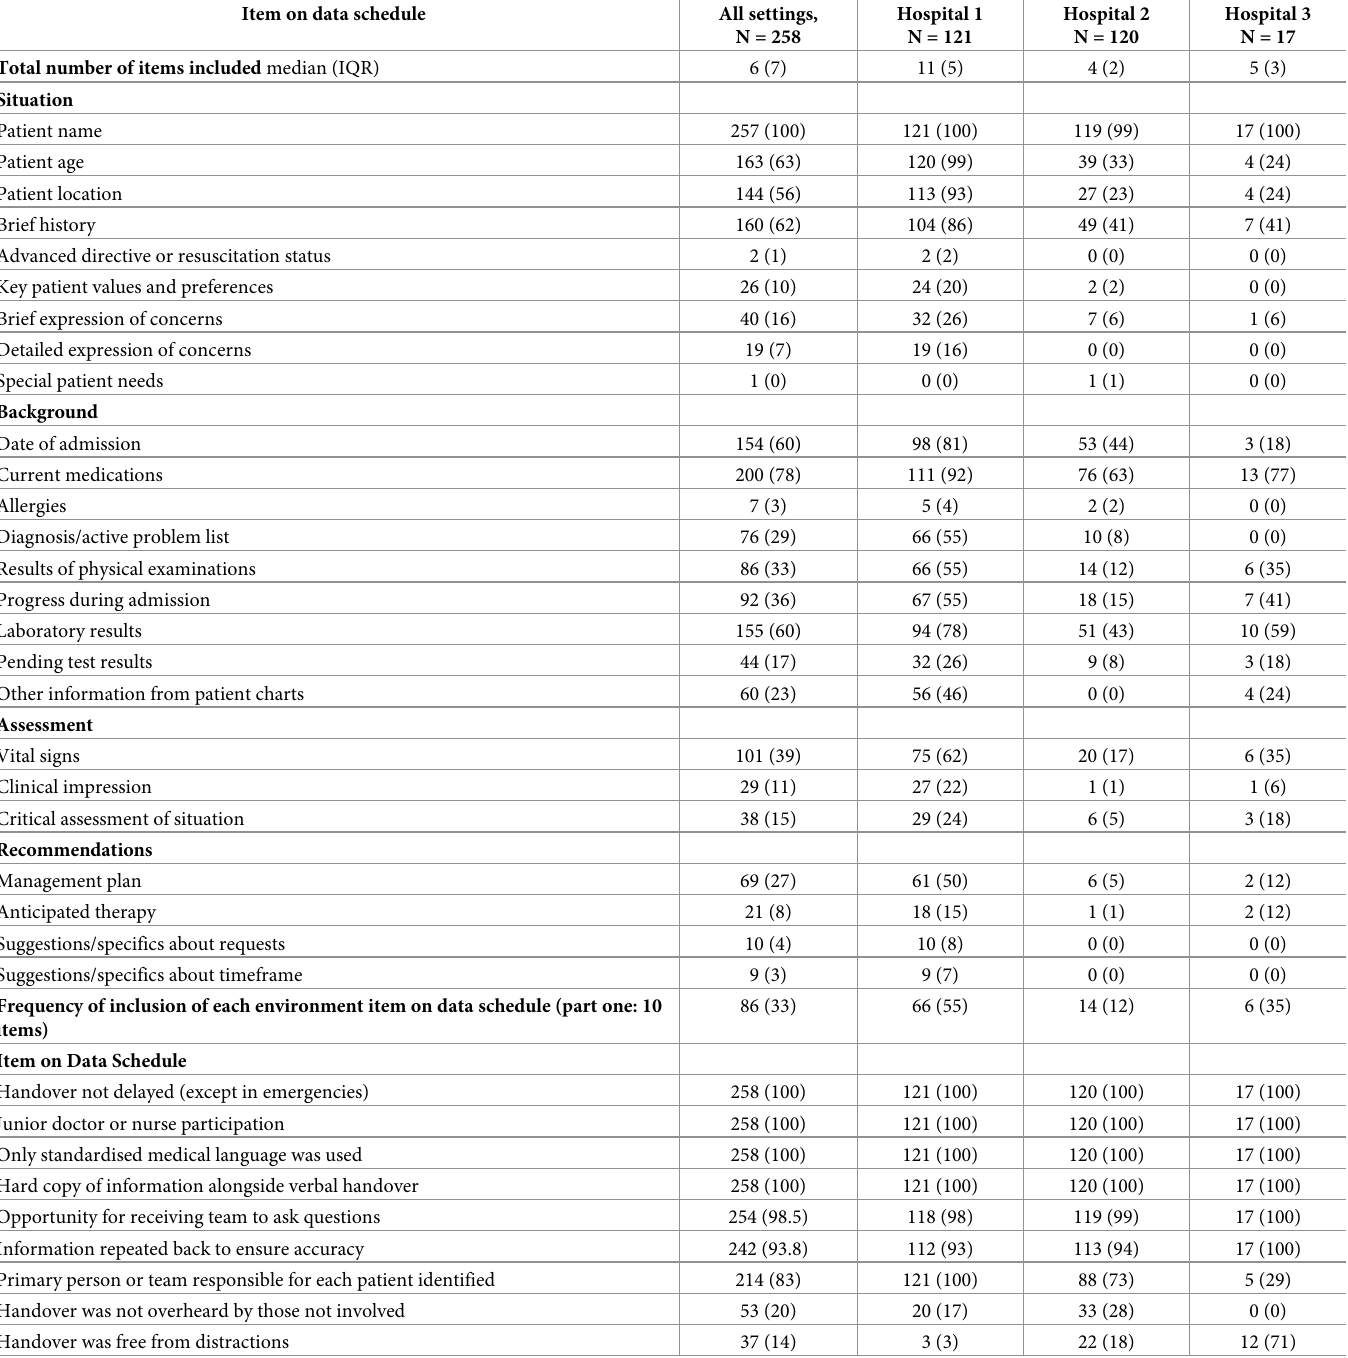
Table 2. Frequency of inclusion of each information item on data schedule (part two: 25 items) and frequency of inclusion of each environment item on data sched- ule (part one: 10